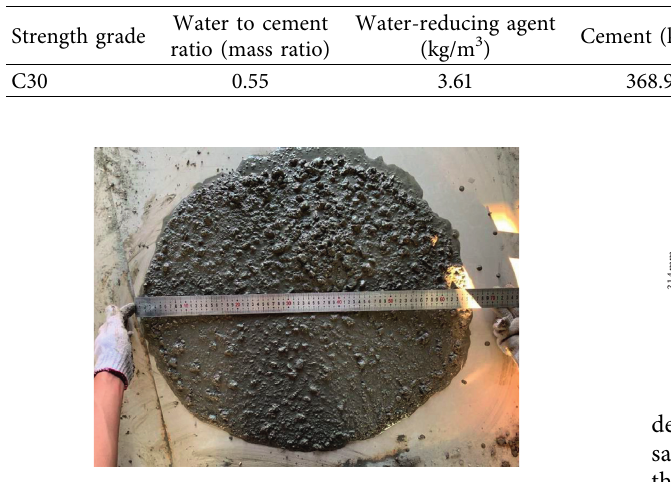
Table 2: Concrete mix design.